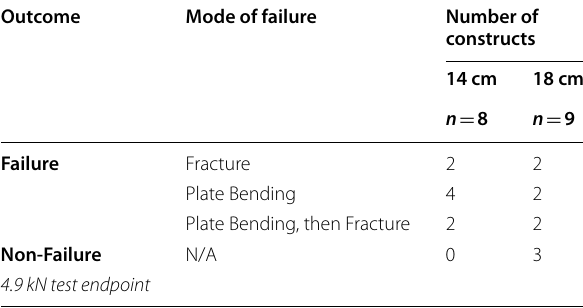
Table 2 Outcomes and modes of failure for in vitro plate‑bone construct mechanical testing. Fourteen of seventeen constructs failed by either bone fracture, plate bending to the point of bone impingement at the opposite cortex, or initial plate bending followed by fracture. Three long plate constructs reached the